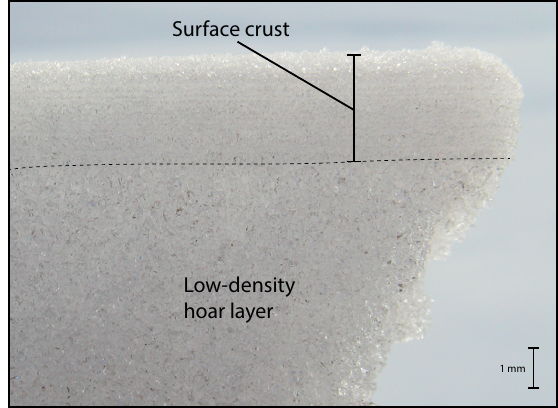
Figure 9. A surface snow sample excavated from a glazed area at WAIS Divide before the onset of polygonal cracking, show- ing a couplet of an evolved ∼ 3mm high-density ( > 400kgm − 3 ), multi-grain surface crust containing single-grain crusts and overly- ing a lower-density ( < 300kgm − 3 ) hoar